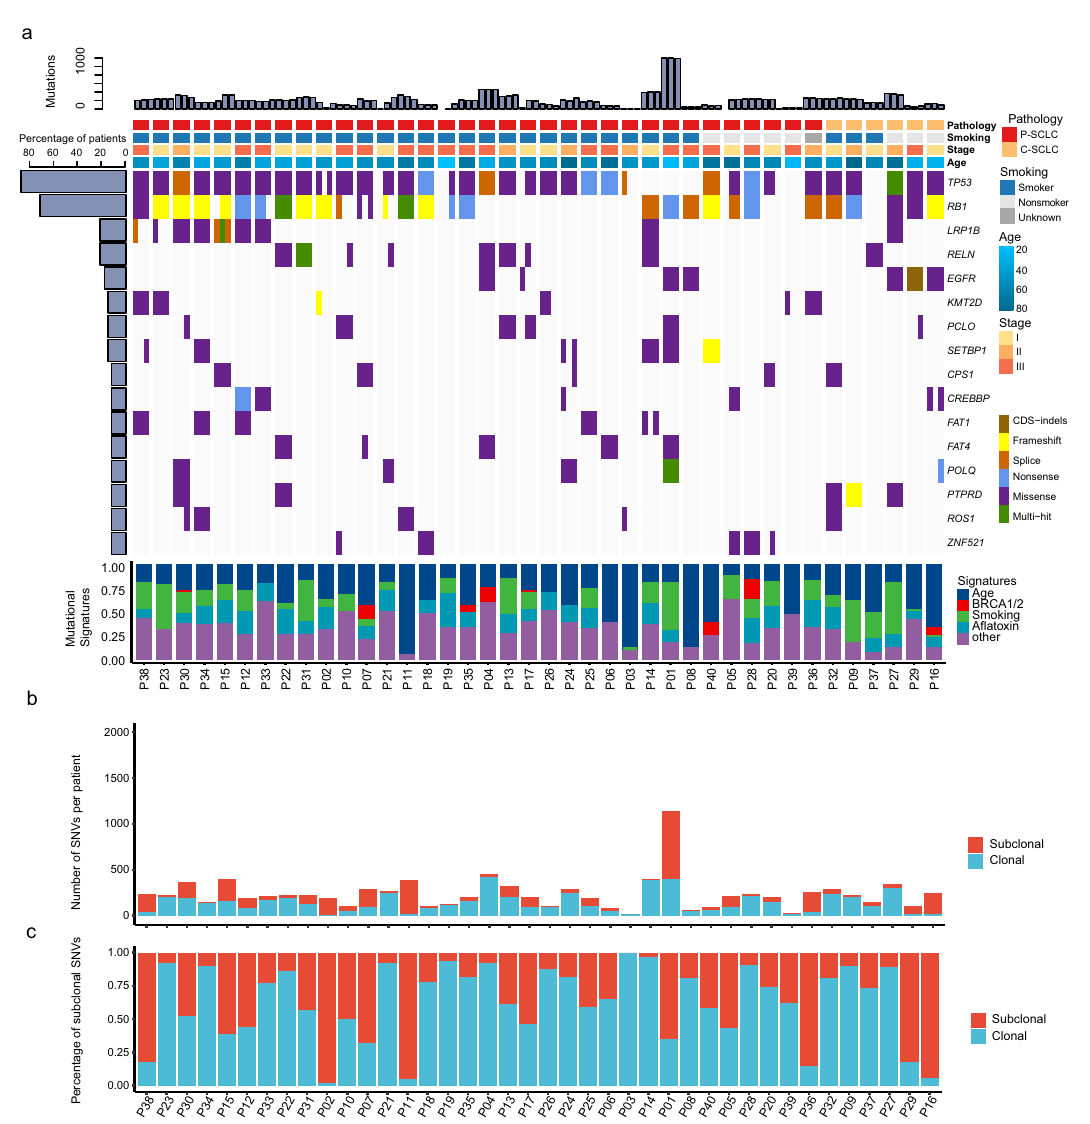
Fig. 1 Mutational spectrum of SCLC. a Mutational landscape of SCLC ( n = 40). Mutated gene frequency >15% involved in previously reported signi fi cant mutated genes in SCLC are shown for each region of the individual patient. Upper, TMB count; middle, heatmap for driver mutations; lower, mutational signatures. b Counts in clonal and subclonal mutations for each patient ( n = 40). c Percentage of subclonal mutations for each patient ( n = 40). SCLC small cell lung cancer, P-SCLC pure small cell lung cancer, C-SCLC combined small cell lung cancer, SNVs single-nucleotide variants, CDS coding